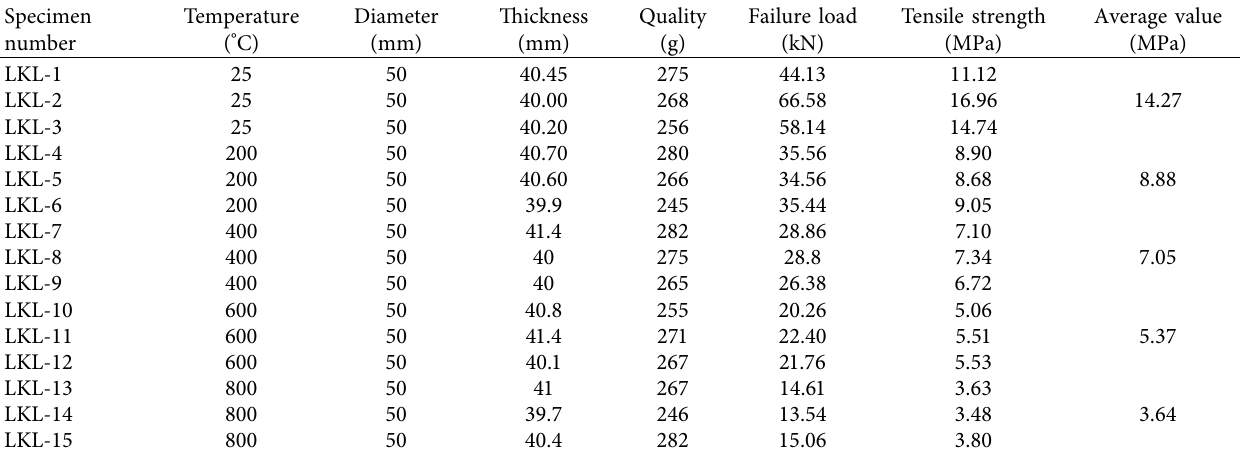
Table 3: Brazilian disc splitting experiment test data (natural